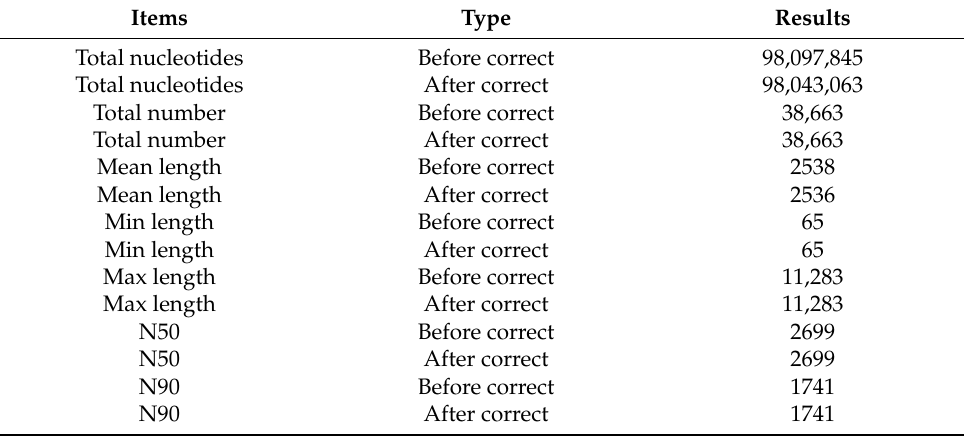
Table 2. Statistical results of length distribution before and after transcript